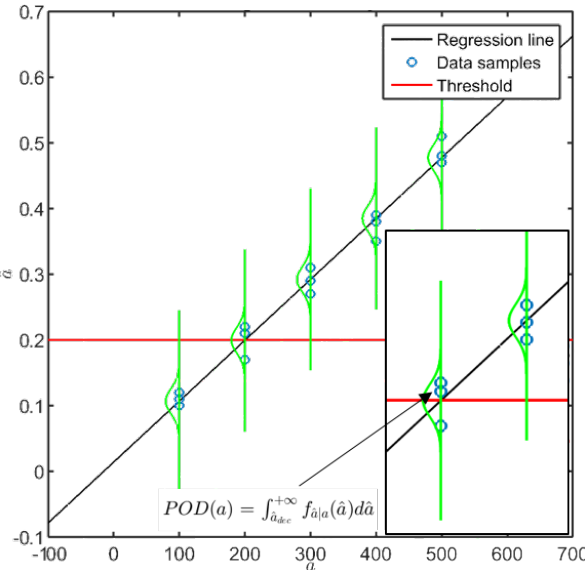
Figure 3. ˆ a vs. a procedure with the regression model and the Gaussian distribution around the predicted value (illustrative